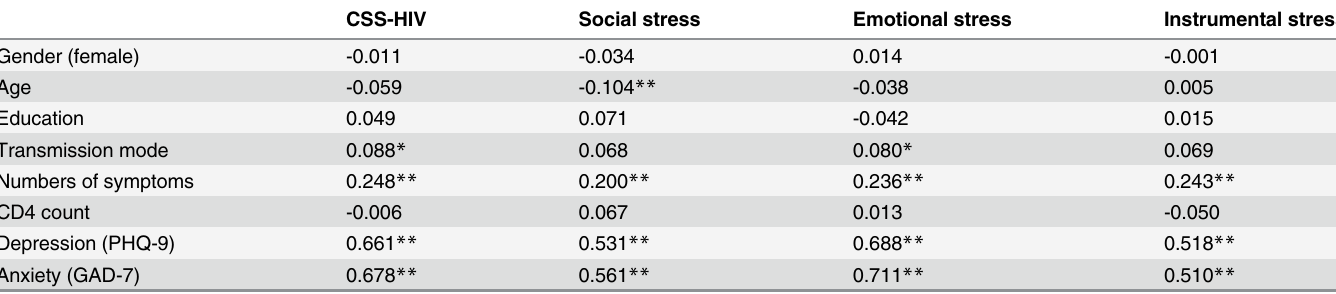
Table 4. Correlation of the 17-item CSS-HIV to demographics and validating